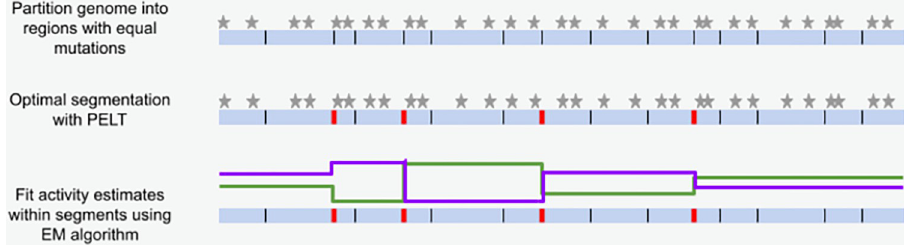
Fig 1. Overview of GenomeTrackSig algorithm for profiling mutational signature activities across the genome. Stars indicate mutations (top); red bars indicate changepoints (middle); green and purple lines indicate estimated mutation signature activities; y-axis indicates exposure level (bottom). GenomeTrackSig requires at least 100 mutations per segment, fewer mutations are shown here for illustrative purposes.